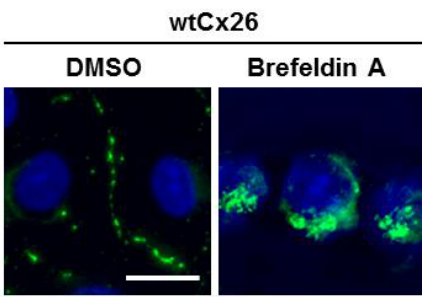
Figure A1. Effect of Brefeldin A on wtCx26-mdiated GJ plaques. Indirect immunofluorescence of Cx26 protein in wtCx26 clone in the presence or absence of 5 µg/mL Brefeldin A/DMSO. The fluorescent signals of Cx26 protein were visualised by Alexa-488. Nuclei were stained with DAPI. Scale bar, 20 µm.